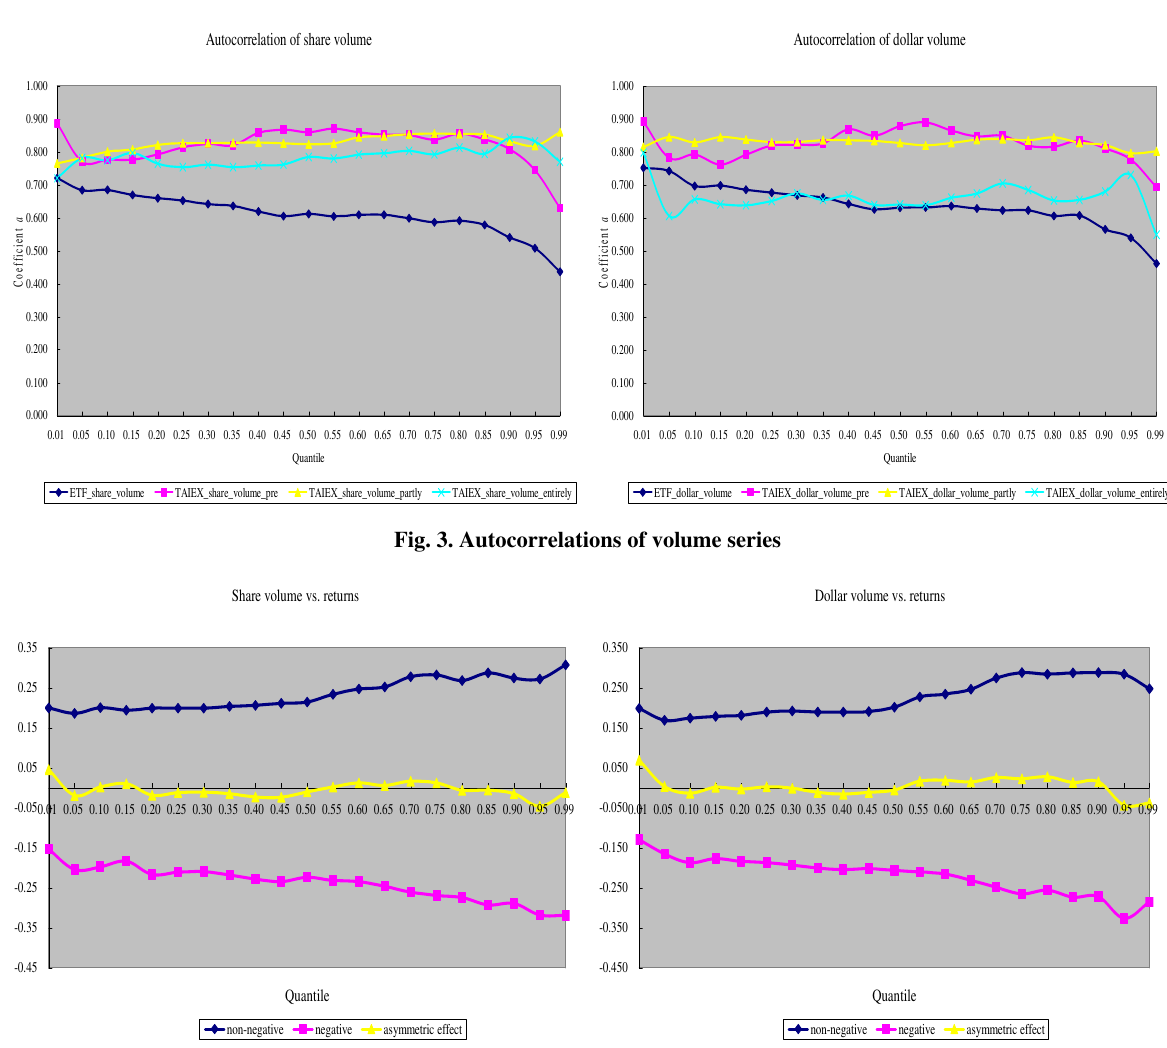
Fig. 4. Quantile regression estimates of volume-signed return correlation for Taiwan 50 ETF in the full-sample